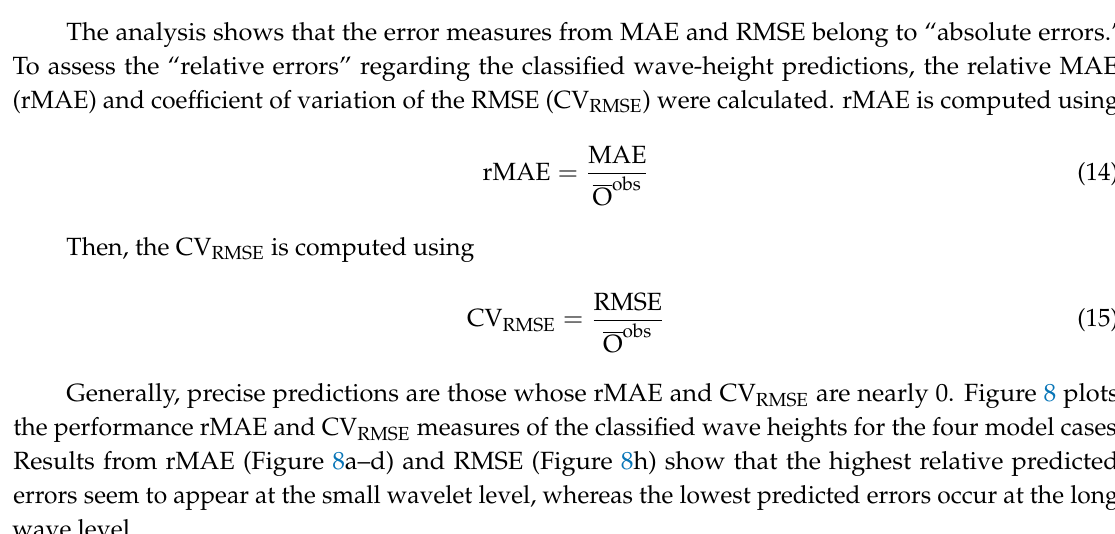
Figure 7. Performance measures of classified wave heights for the four PCA cases: ( a – d ) MAE, ( e – h ) RMSE, and ( i – l ) r. MAE: mean absolute error.